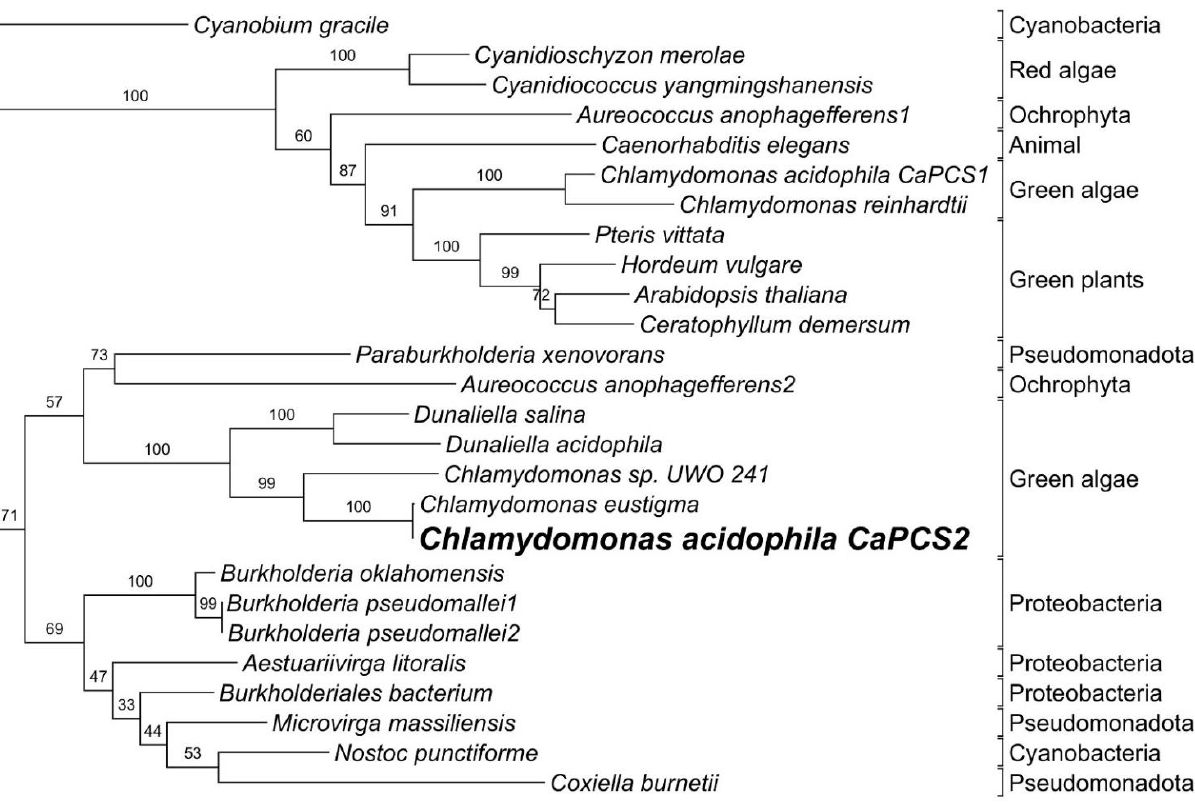
Figure 7. Phylogenetic relationships of CaPCS2 and the most similar genes obtained with a protein BLAST, together with a selection of other known PCS genes. The tree represents the bootstrapped majority consensus IQ tree.